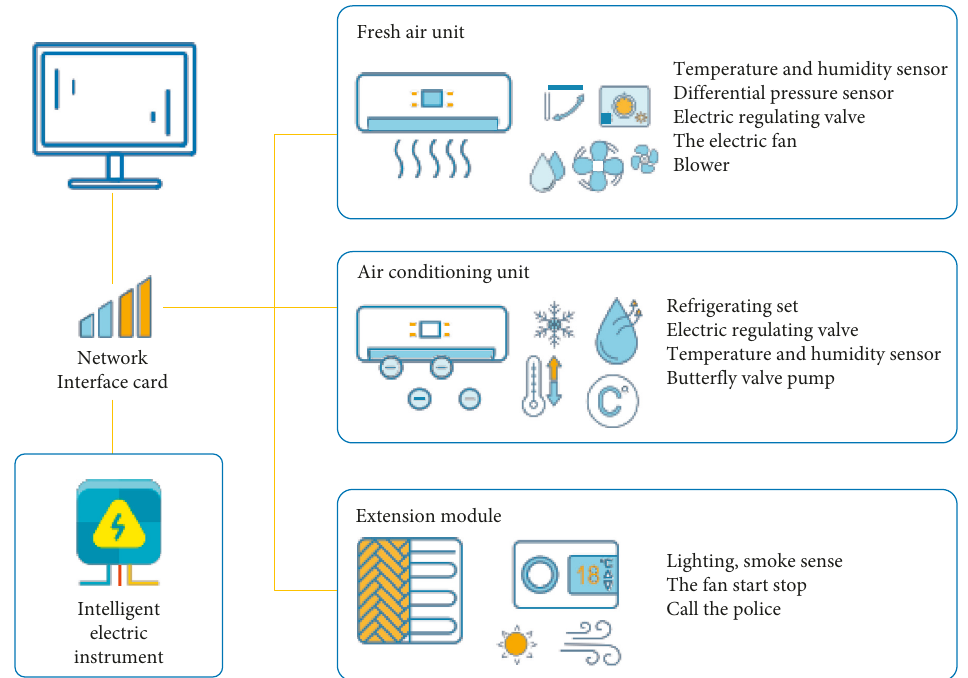
Figure 1: Energy-saving model of central air